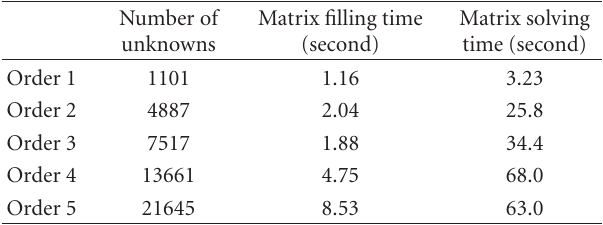
Figure 3: PEC sphere with the radius of 1.0 meter.